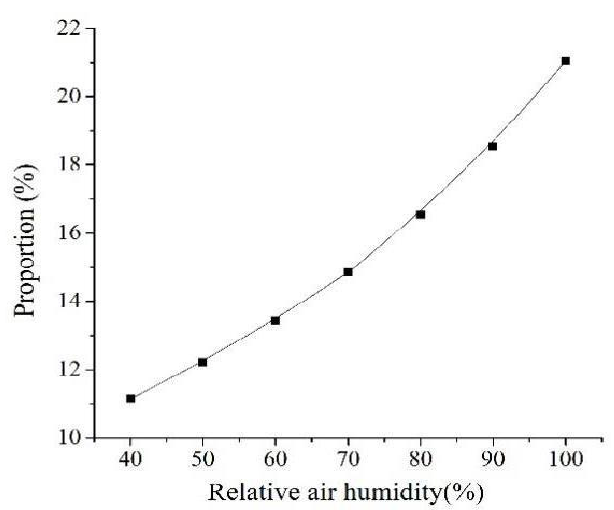
Figure 9. Variation in evaporation loss calculated by Xia [10].